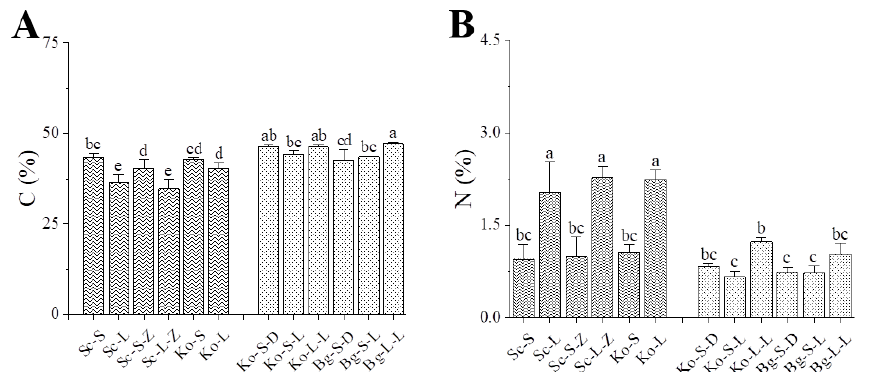
Figure 2. Contents of C ( A ) and N ( B ) from mangrove plant samples in K. obovata and S. caseolaris communities on the west coast of Bao ’ an, Shenzhen. Mean ± SD of three replicates were shown. Different small letters indicate significant differences among the contents of C and N in the leaves or stems from Sc, Ko, and Bg at p < 0.05. Note: in the abscissa, “Sc” means S. caseolaris , “Ko” means K. obovata , “Bg” means B. gymnorrhiza , “S” means stems, the first “L” means leaves, “Z” means S. caseolaris collected near a side of the Zhujiang River Estuary (out of the sampling plots Sc 6 – 8 ), “D” means dead, and the second “L” means living. Samples without the second letter, such as Sc-S, Sc-L, Ko-S, and Ko-L, were collected from the S. caseolaris community.